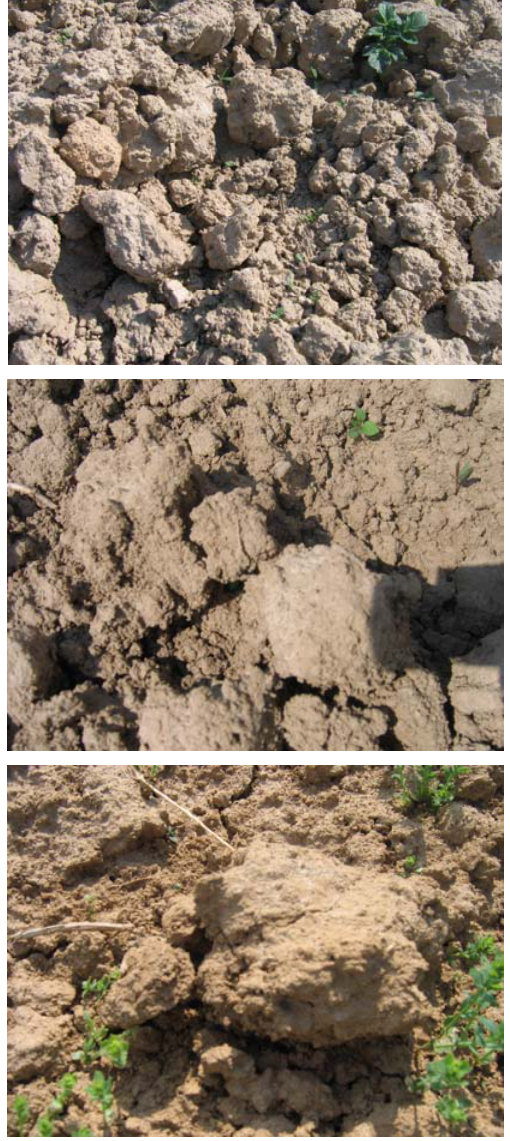
Figure 3. Illustration of real agricultural soils.